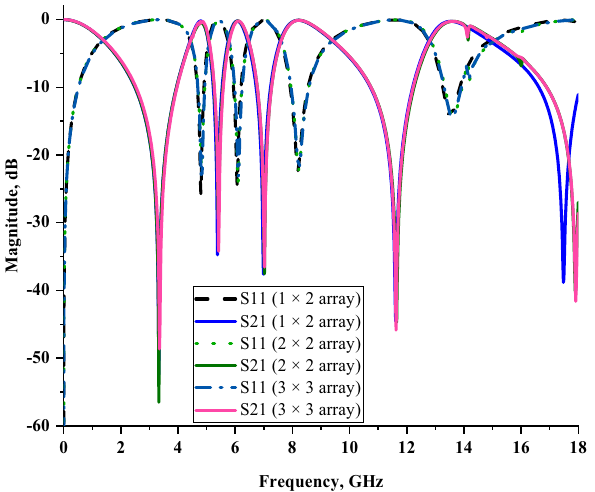
Figure 9. Comparison of reflection and transmission coefficient results of SQM array cells.